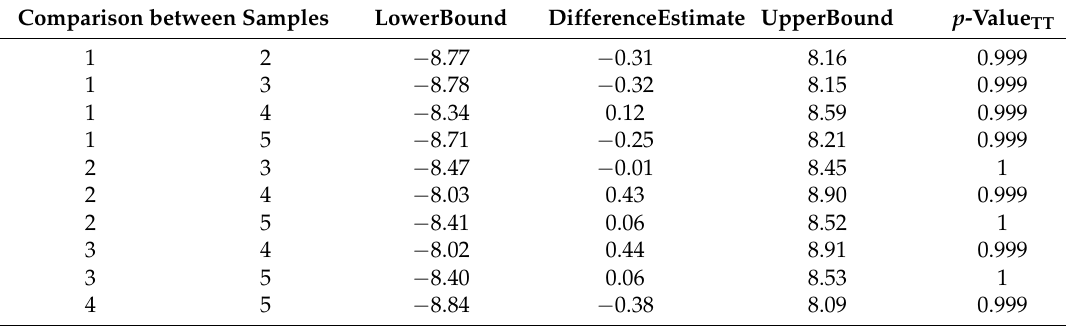
Figure 5. Mean value of the energy produced by each array for the one-month analysis (January). Table 2. One-to-one comparison of the means for the one-month analysis (January). Comparison between